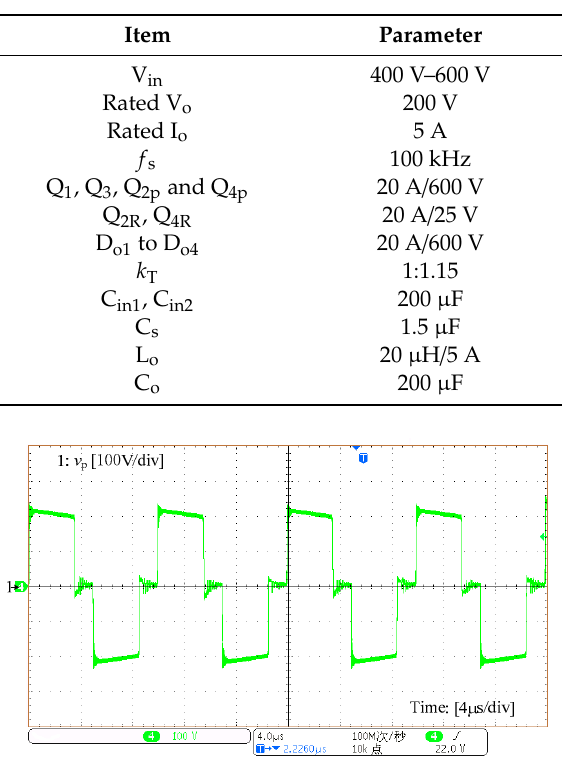
Figure 7. Waveform of i p . Figure 8. Waveform of Δ v Cin2 . The soft-switching characteristic of Q 2P is proved in Figure 10, and it is clear that Q 2P can achieve ZVZCS. Before the switch-on instant, i Q2P conducts in the reverse direction owing to the fact that D 2P is already on, hence, Q 2p is switched on with zero-voltage. Before the switching-off signal of Q 2P is coming, i 2P reduces to zero. Therefore, Q 2P can achieve ZCS turn-off properly. v Q3 , i Q3 and v GSQ3 are depicted in Figure 11, which proves Q 3 is operated in ZCZVS. At the time of switching-on, i Q3 cannot change sharply owing to the fact that L lk limits the changing rate of i p , thus, Q 3 is switched with quasi-ZCS mode. At the time of switching-off, v Q3 cannot change sharply owing to the fact that C 3 limits the changing rate; therefore, the switching-off power loss of Q 3 is also small. It should be pointed out that a large value of C 3 would not take great effect on ZVS turn-on of Q 3 , which means both the turn-on and turn-off switching loss of Q 2P and Q 3 can be optimum. As proved in Figures 10 and 11, the voltage stress of Q 3 and Q 2P is confined close to V in /2.